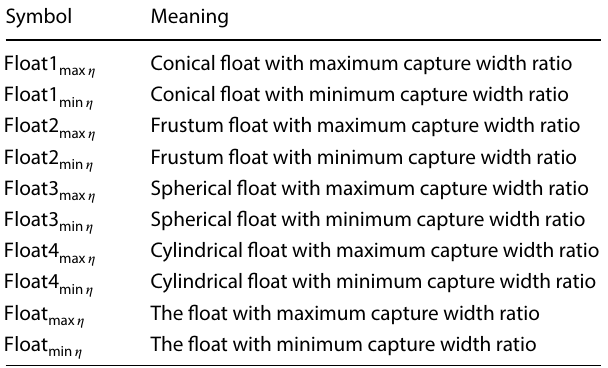
Table 7 The meaning of the float symbol